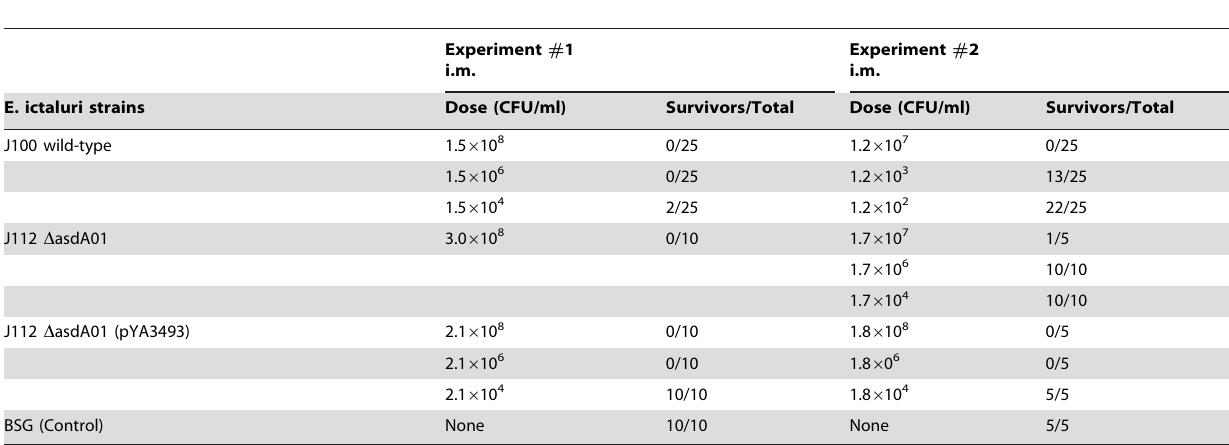
Table 3. Survival of zebrafish ( D. rerio ) infected with wild-type and E. ictaluri D asdA01 with and without Asd + vectors.